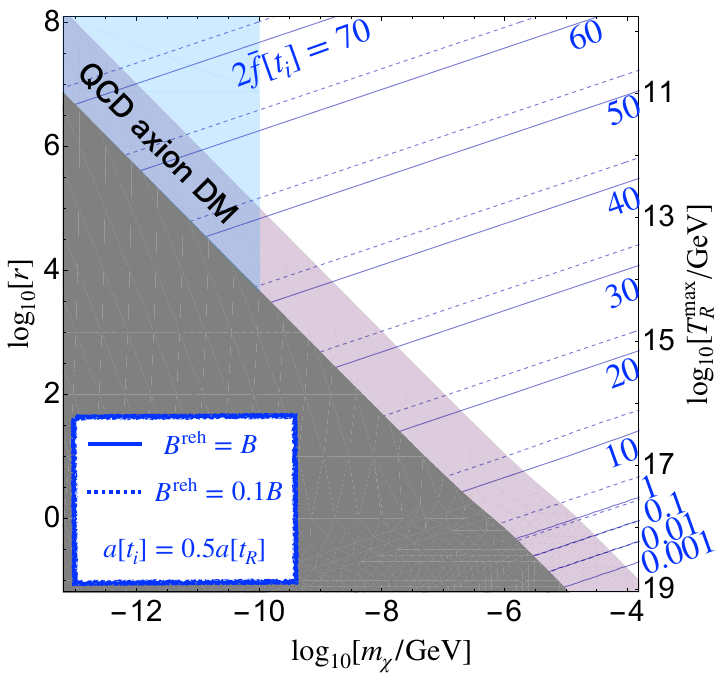
Figure 2 . The contour of 2 ¯ f ( t i ) of a bosonic DM in m χ - r plane by requiring Ω χ h 2 = 0 . 12 with B (reh) = B (blue solid) and B (reh) = 0 . 1 B (blue dotted). We assume a ( t i ) = 0 . 5 a ( t R ) . See figure 1 for the meanings of the color-shaded